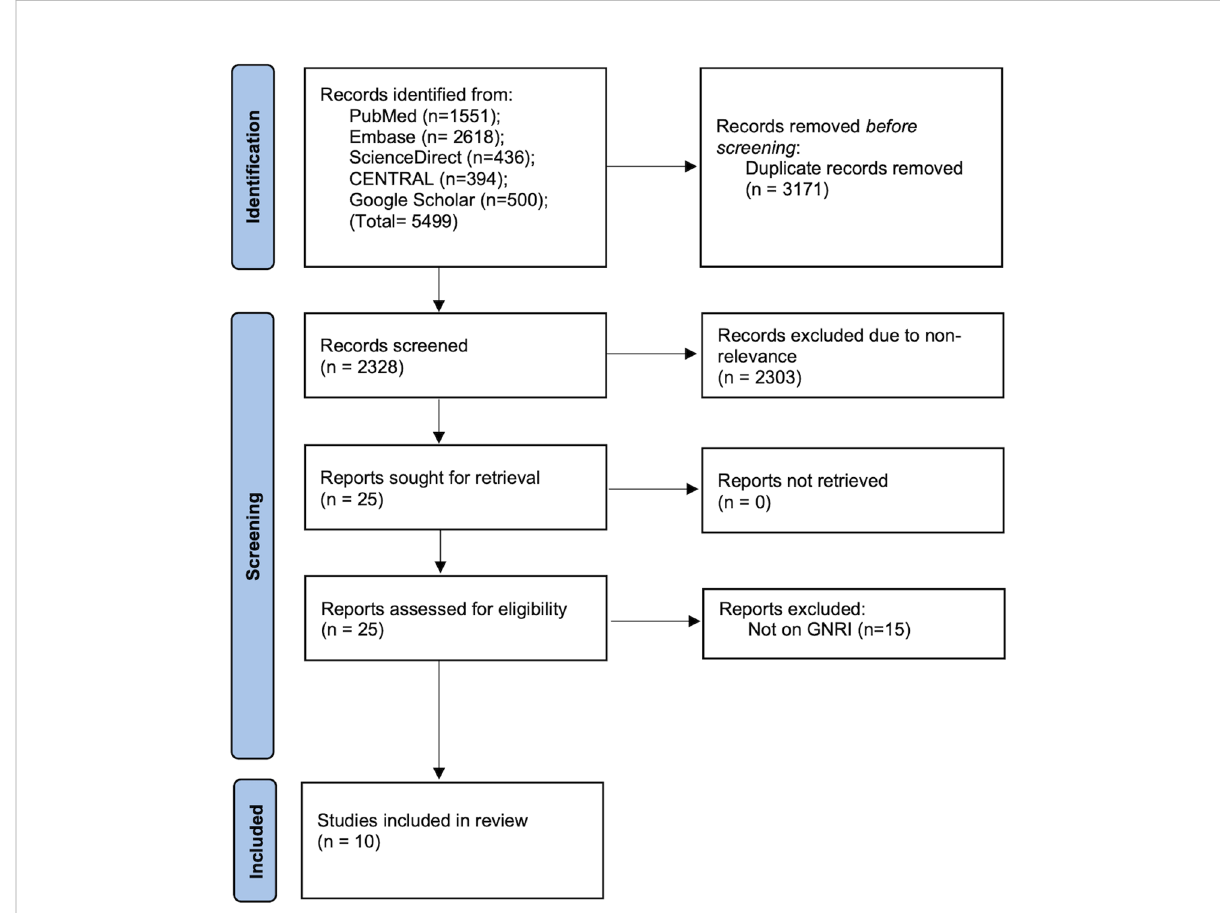
FIGURE 1 Details of literature search in the PRISMA fl